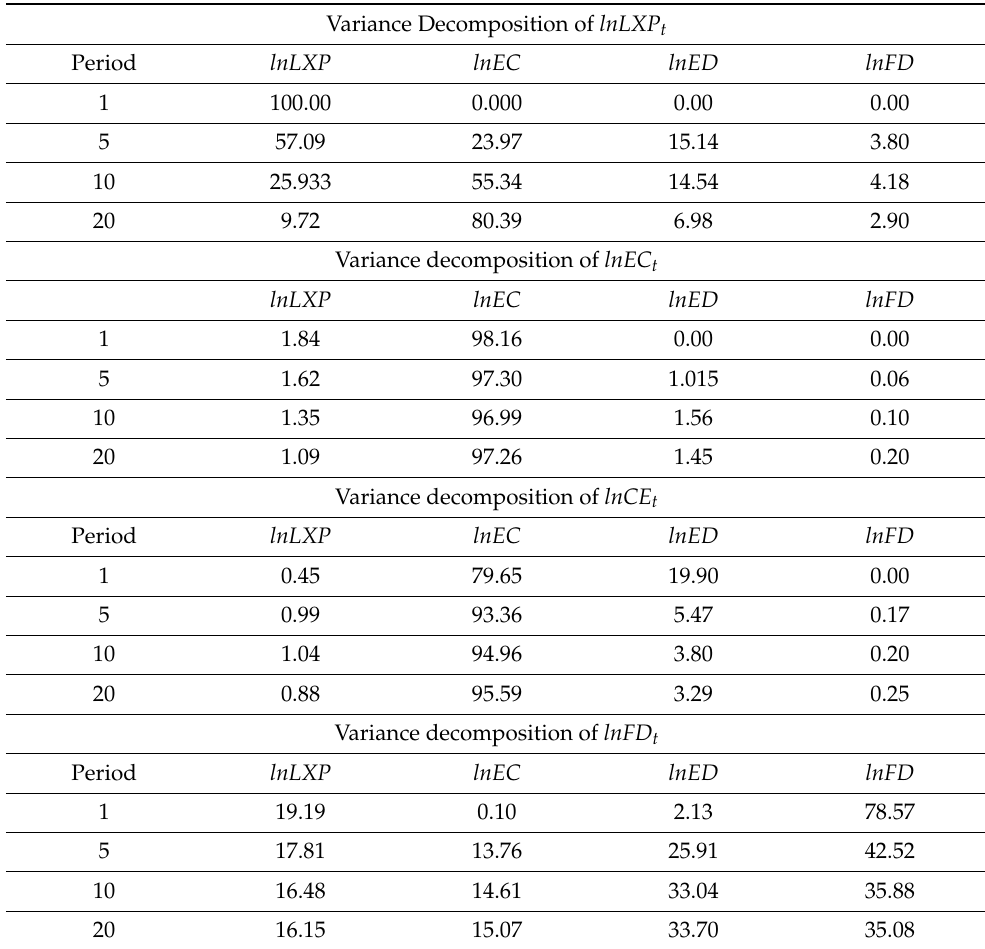
Table 10. Results of Variance Decomposition for Health Outcomes (Life Expectancy). Variance Decomposition of lnLXP t